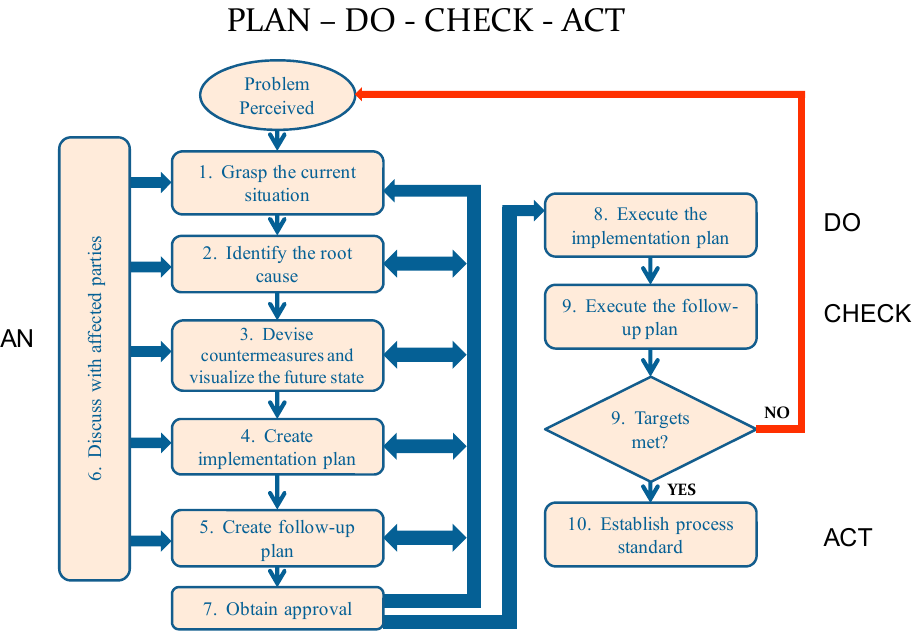
Figure 2. The PDCA Processes (extracted from Sobek and Smalley [34], page 20).